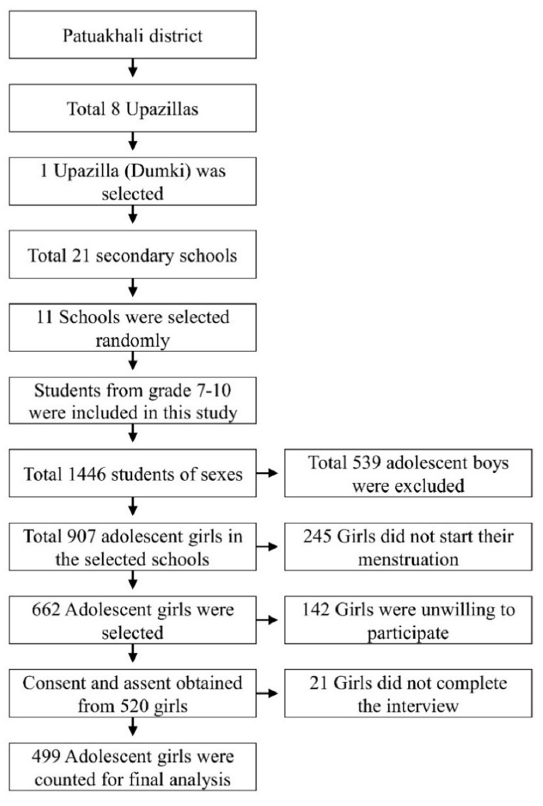
Figure 1. Participant enrollment procedure for this study.